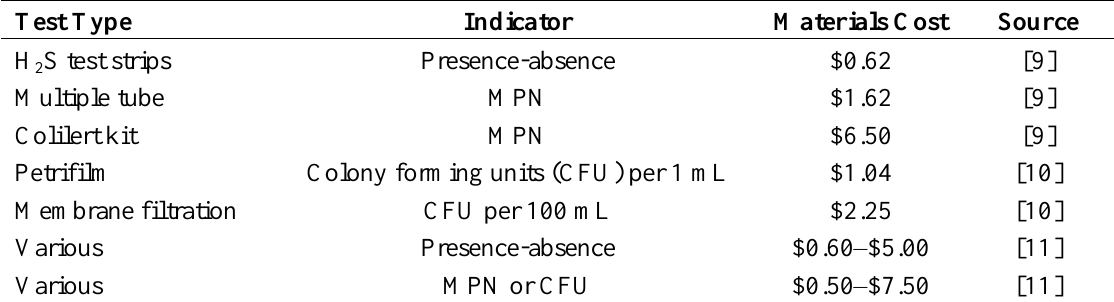
Table 4. Test materials cost figures from published